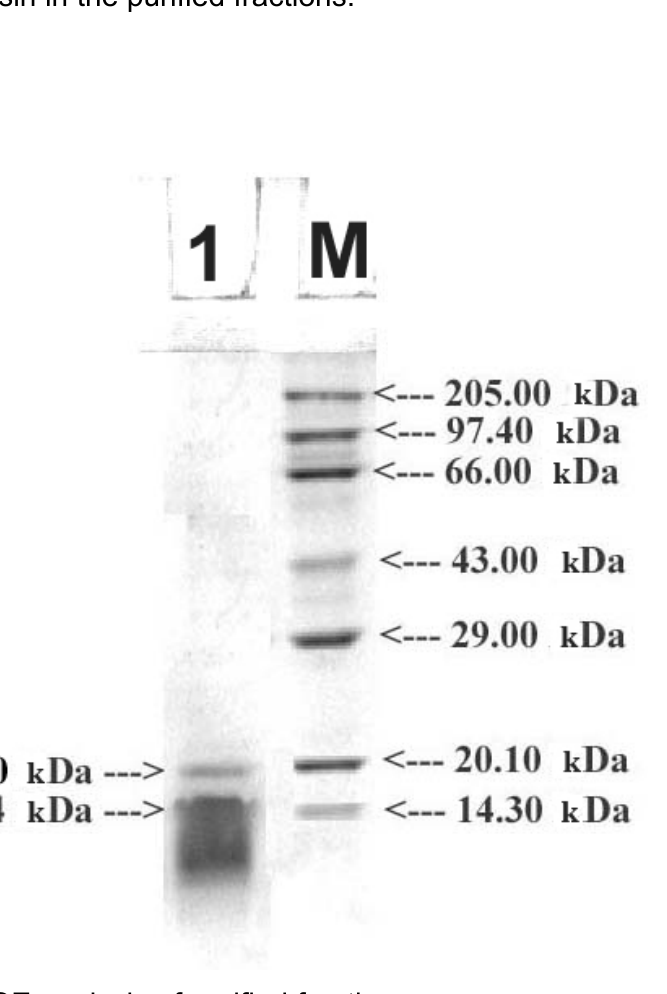
Figure 6. SDS-PAGE analysis of purified fractions. M: standard protein molecular weight marker. Lane 1: pooled active fractions from the cation- exchange